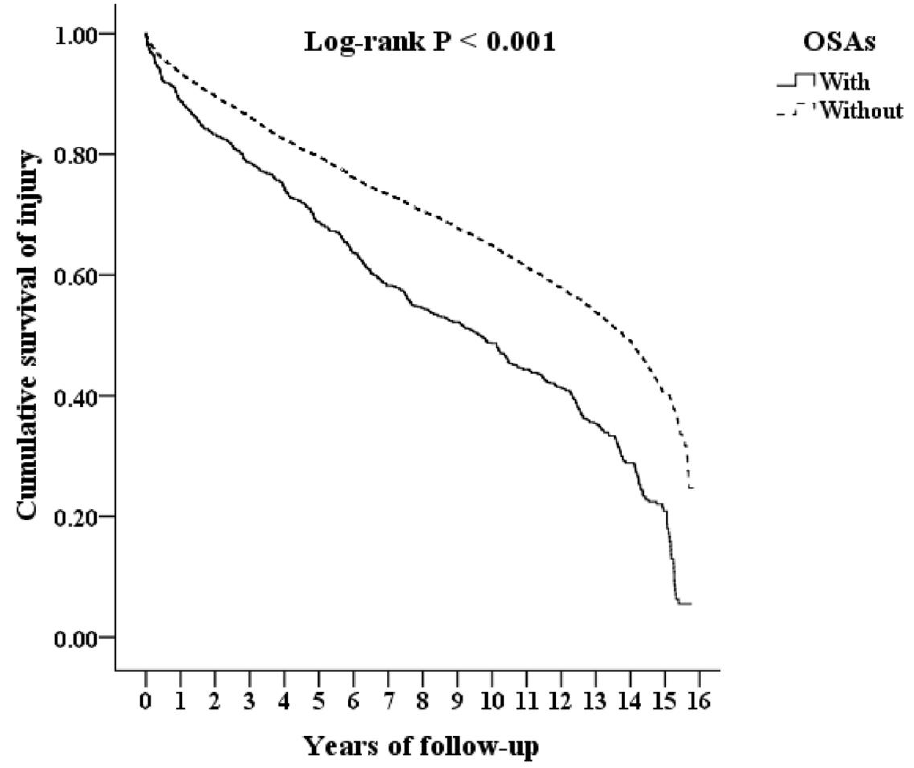
Figure 2. Kaplan-Meier for cumulative survive of injury among aged 20 and over stratified by OSAs with log-rank test.